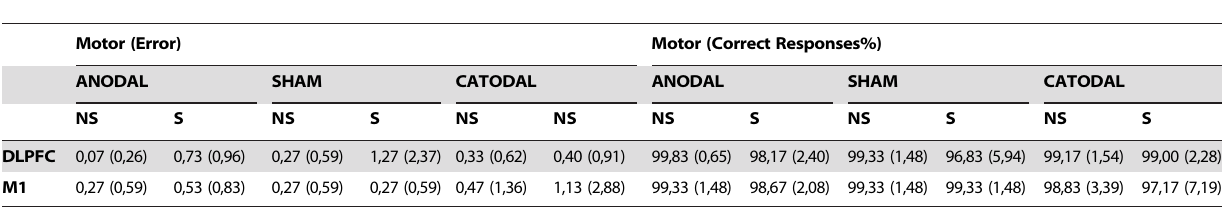
Table 2. Mean Number of errors and percentage of correct responses for the motor task.